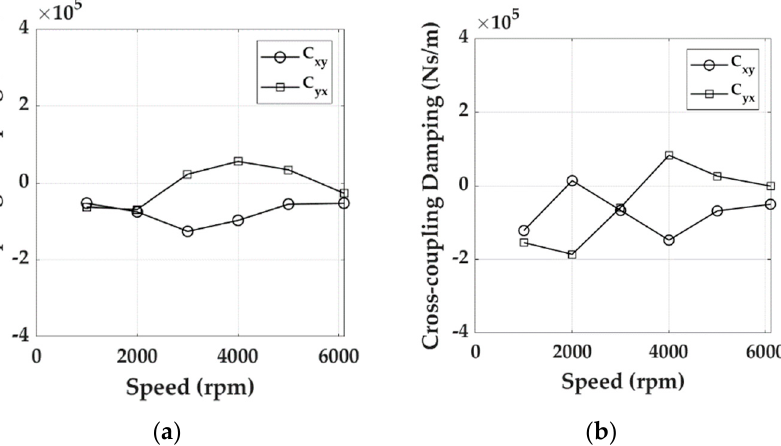
Figure 38. Flooded Ball & Socket Pivot bearing synchronous cross-coupling damping: ( a ) 1.0 MPa, ( b ) 1.7 MPa.